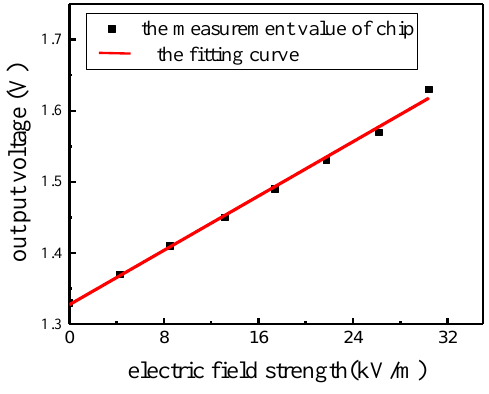
Figure 9. The measurement results in an electrostatic field.